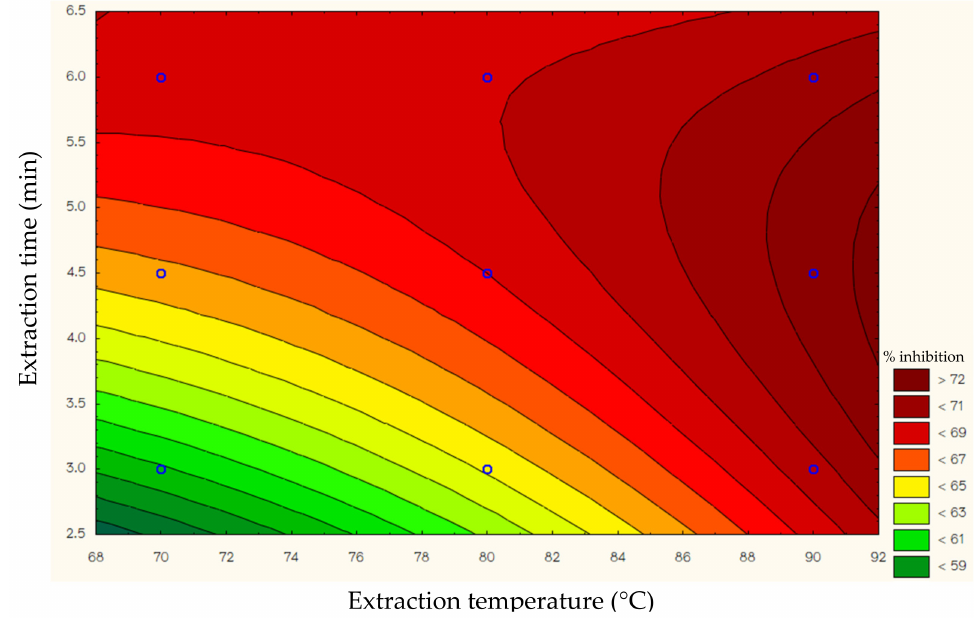
Figure 1. Contour plot for antioxidant activity as a function of extraction temperature and